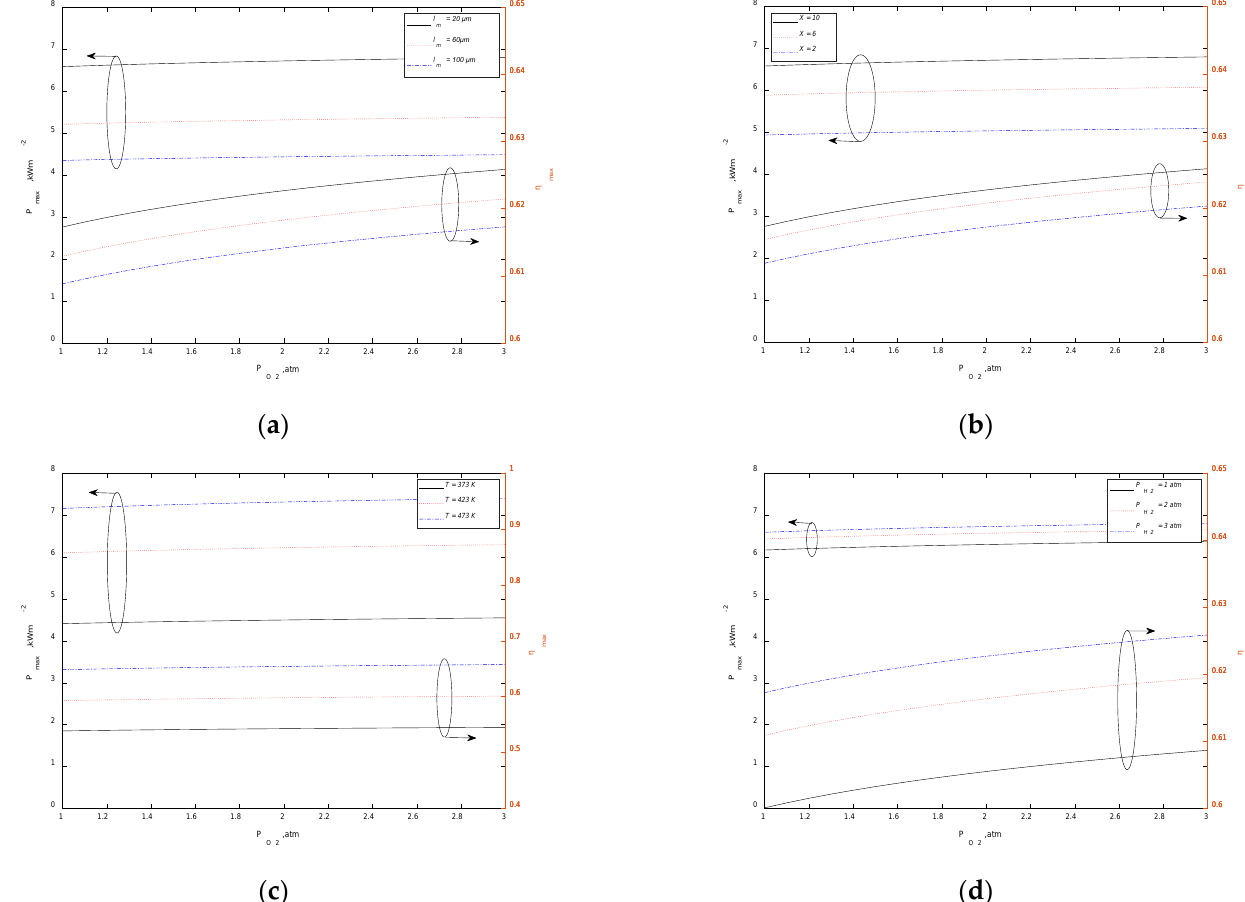
and of HT-PEMFC under different parameters. ( a ) Different . 2 𝑃𝑃 𝑚𝑚𝑚𝑚𝑚𝑚 𝜂𝜂 𝑚𝑚𝑚𝑚𝑚𝑚 𝑝𝑝 𝐻𝐻 2